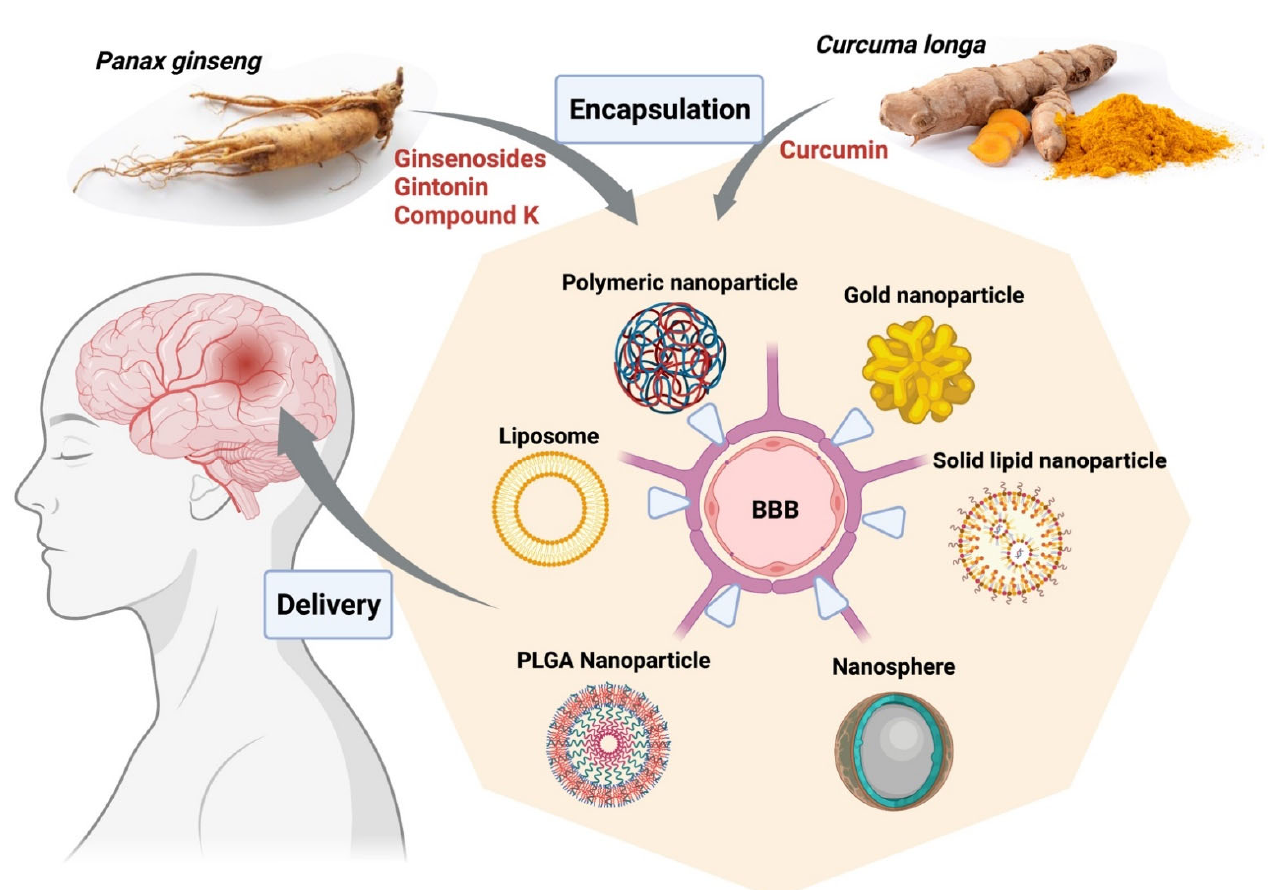
Figure 2. Encapsulation of bioactive compounds from herbal extracts of Curcuma longa and Panax ginseng into various nanoparticle platforms facilitates delivery to targeted areas in the brain from the blood, improves solubility, and enhances retention rates. The figure was made with www.biorender.com (access date: 12 January 2022). Abbreviations: BBB, blood-brain barrier; PLGA, poly ( D , L -lactic acid ‐ co ‐ glycolic acid). Table 1 . Nano ‐ formulations of active compounds or extracts from curcumin and ginseng for neu ‐ rological disorders.